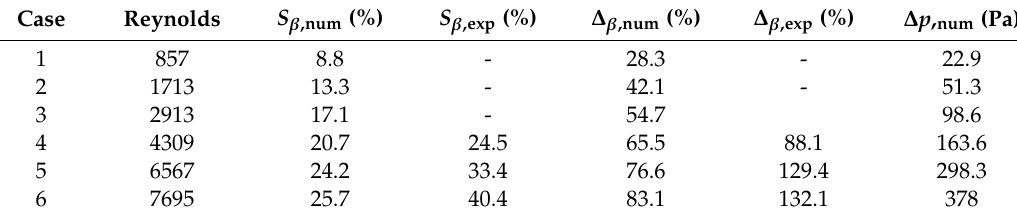
Table 3. Numerical and experimental values of metrics S β and ∆ β for the six cases. Predicted pressure drop is also tabulated. (Numerical results refer to laminar flow simulations in grid A).